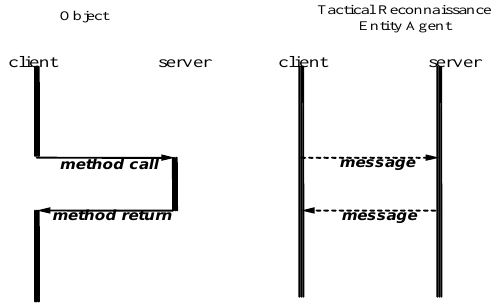
Fig. 3. Comparison of an object and a tactical reconnaissance entity